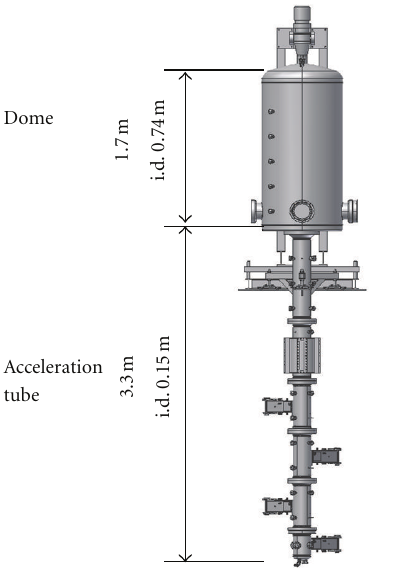
Figure 5: ENACCEF experimental facility for performing experi- ments on hydrogen